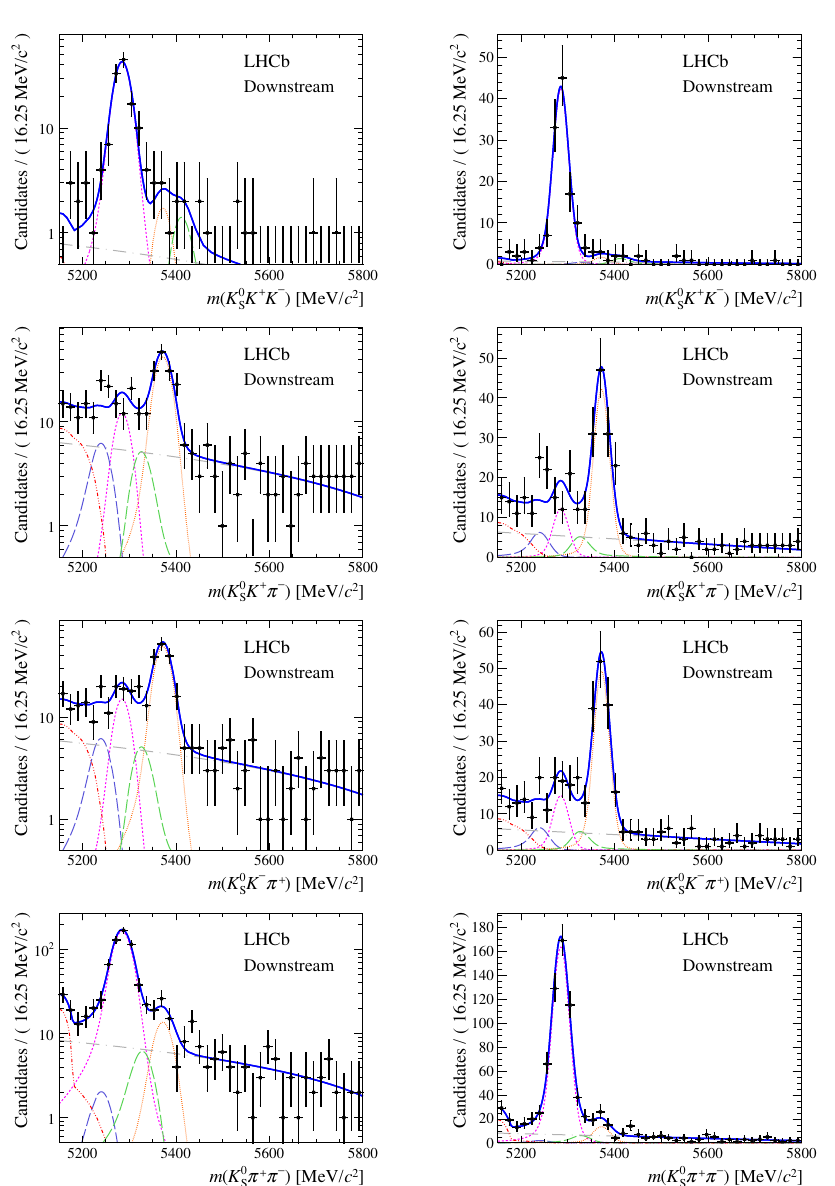
Figure 9 . Results of the simultaneous (cid:12)t to data (downstream, 2011) with the BDT optimisation corresponding to the suppressed modes. The modes K 0 are shown from top to bottom. The left-hand side plots show the results with a logarithmic scale and the right-hand side with a linear scale. Legend is similar to that of plots shown in (cid:12)gure 1.